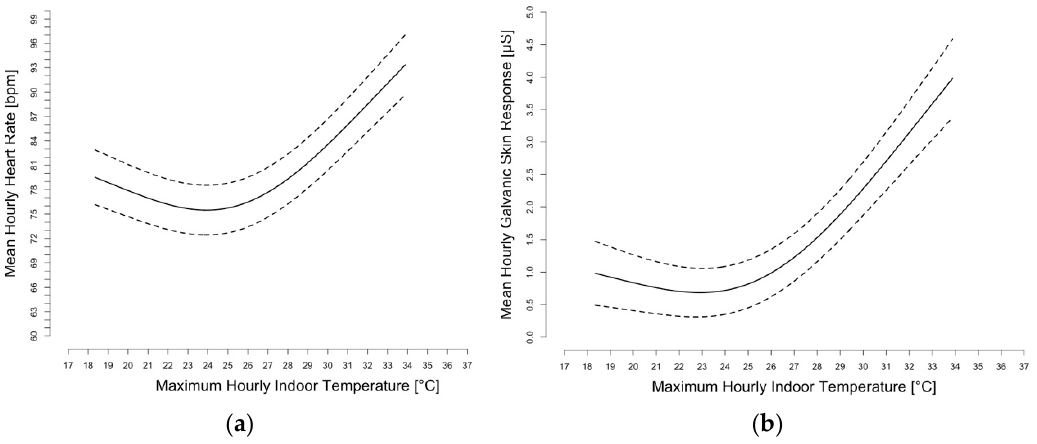
Figure 4. Non-linear association between hourly indoor temperatures and mean hourly heart rate (HR), after adjusting for building ( a ). Non-linear association between hourly indoor temperatures and mean hourly log-transformed galvanic skin response (GSR), after adjusting for building, and HR ( b ). The dotted lines represent the 95% confidence intervals.